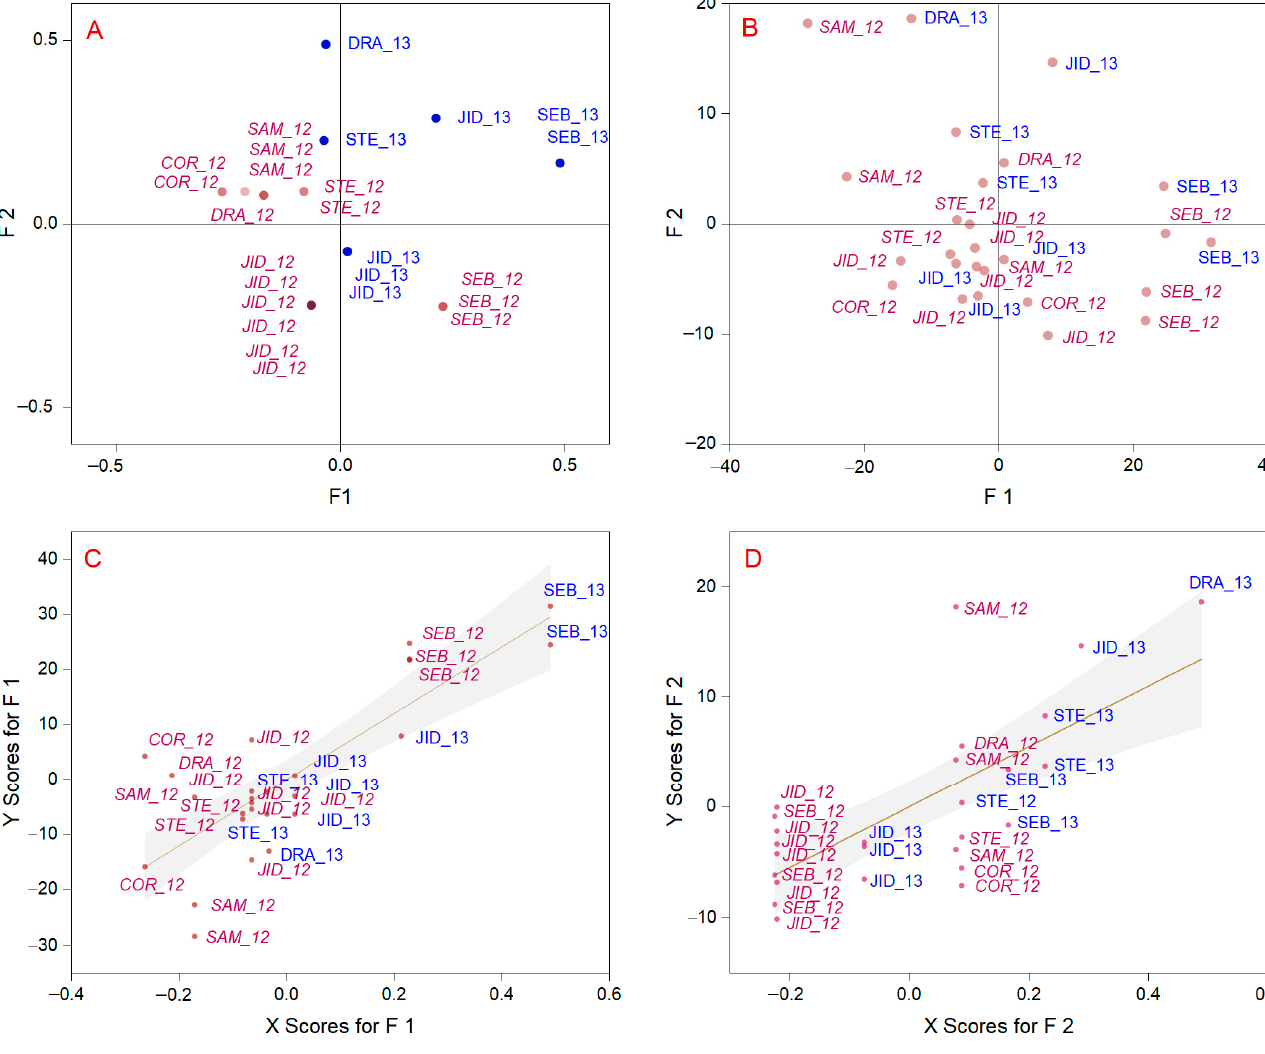
Figure 5. Discriminant analysis (PLS-DA) score plot of the first two principal components. The 95% confidence ellipse is included in the score plot. ( A ) X score plot; ( B ) Y score plot; ( C ) fitted X1-Y1 score plot; ( D ) fitted X2-Y2 score plot. The names represent the abbreviation of the vineyard (the first three letters) followed by the capitalization year, marked with read (2012 year) and blue (2013 year).